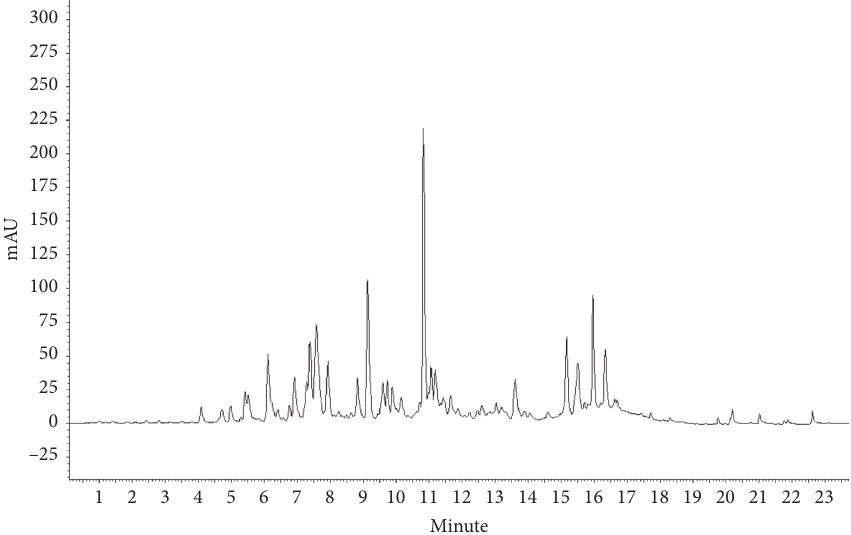
Figure 1: HPLC-UV profiles (285nm) of orange juice extract (XAD-16N).